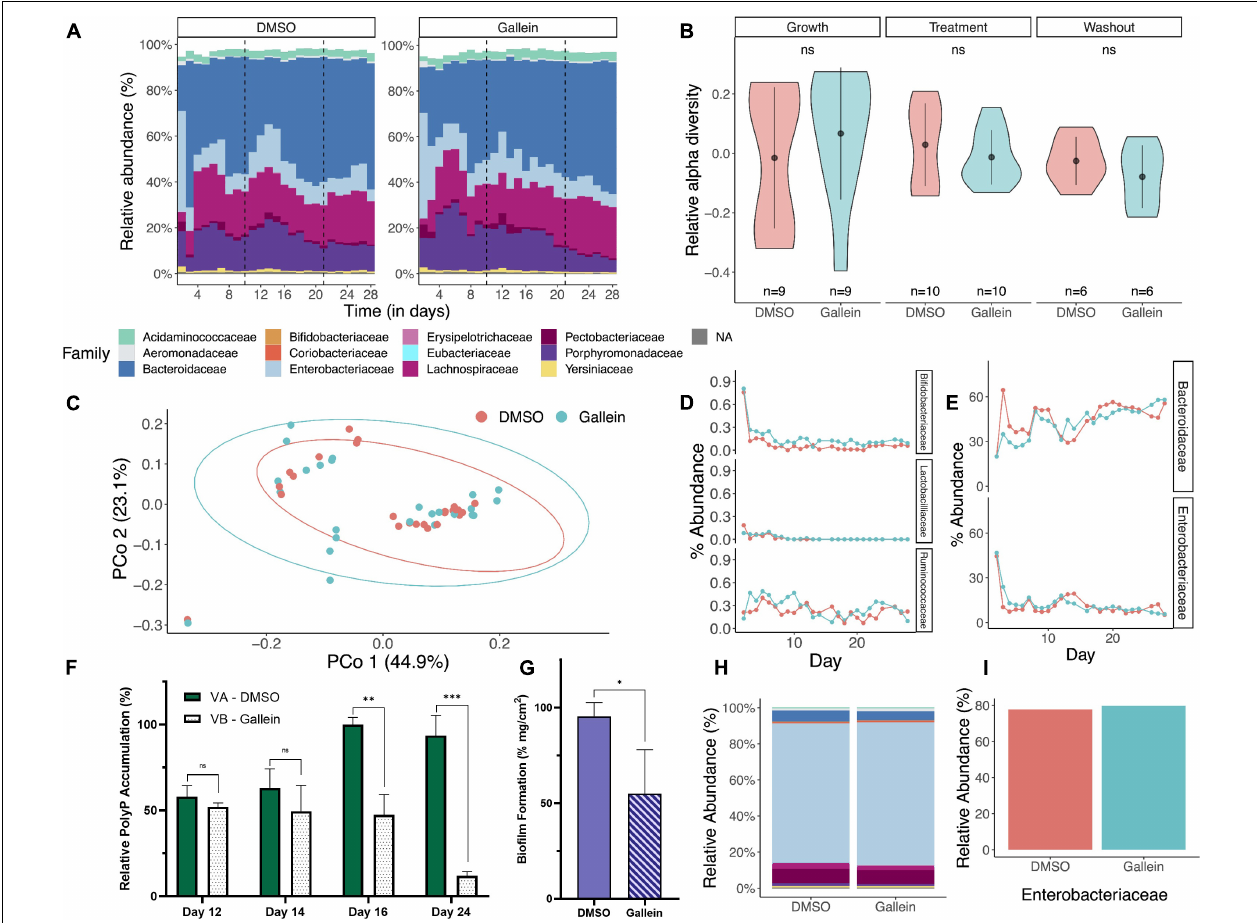
FIGURE 5 | Gallein does not reduce microbial viability in a chemostat model despite metabolically influencing cellular populations. Metagenomic analysis of 16S rRNA sequencing data shows bacterial diversity in chemostats treated with gallein vs. DMSO vehicle over time (growth, treatment, washout phase). (A) Relative abundance at the family taxonomic level demonstrates similar composition and distribution following treatment with DMSO or 100 µ M gallein. Taxa with a relative abundance less than 5% are combined in white space at the top of each column. (B) A violin plot depicting the relative alpha diversity by phase and condition shows no significant difference when comparing condition and phase (Mann–Whitney U -test, p growth = 0.2973, p treatment = 0.9705, p washout = 0.5887). Markers and whiskers showing mean ± SD (C) Principal coordinate analysis (PCoA) ordination using Bray-Curtis distance showed no distinct clustering by treatment (PERMANOVA: R2 = 0.01823, p = 0.44). (D,E) Percent relative abundance at the family taxonomic level over the experimental time course for representative Gram positive and Gram negative bacteria, respectively. (F) Quantification of total bacterial polyP on select days in DMSO control Vessel A (VA) and gallein treated Vessel B (VB). (G) Quantification of adhered dry biological mass per cm 2 of waste outflow tubing for each chemostat vessel. (H) Metagenomic analysis of 16S rRNA sequencing demonstrates a similar relative abundance of bacteria at the family taxonomic level in the biological material adhered to the waste outflow tubing of each chemostat vessel. (I) Percent relative abundance of bacteria belonging to the Enterobacteriaceae family within the biological material adhered to the chemostat waste outflow tubing. Symbols are as follows: ns, p > 0.05; ∗ p < 0.05; ∗∗ p < 0.01; ∗∗∗ p < 0.001 (two-way Unpaired t -test). For (F) data points are the average